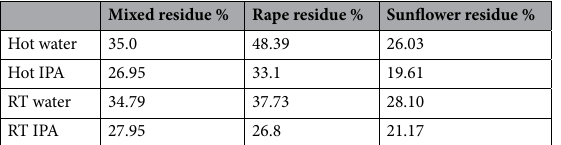
Table 2. Alteration of the dry mass of bee pollen samples following aqueous and IPA washes at different temperatures.